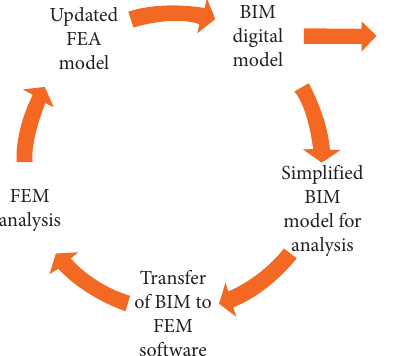
Figure 3: Ideal integration of BIM and FEM software (based on